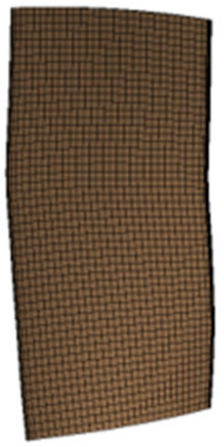
Figure 11. Finite element mesh of R1 rotor blade.